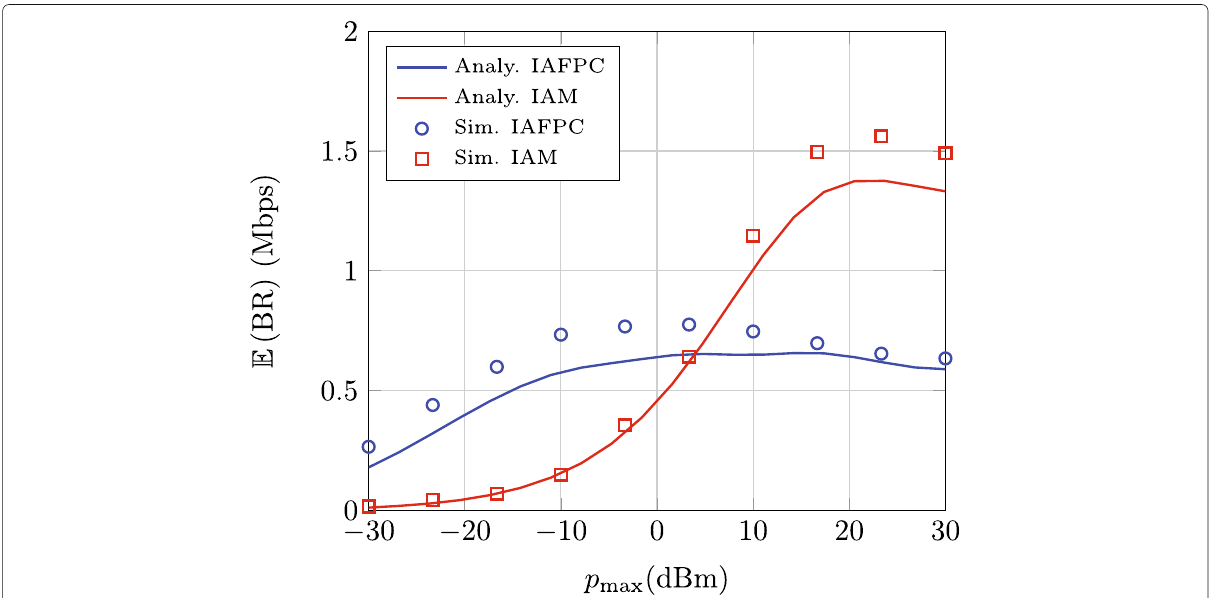
Fig. 9 Comparison of average BR of IAFPC and IAM for (cid:5) = 1, t ( 1 ) / t ( 2 ) = 9 dB and i 0 = − 90 dBm